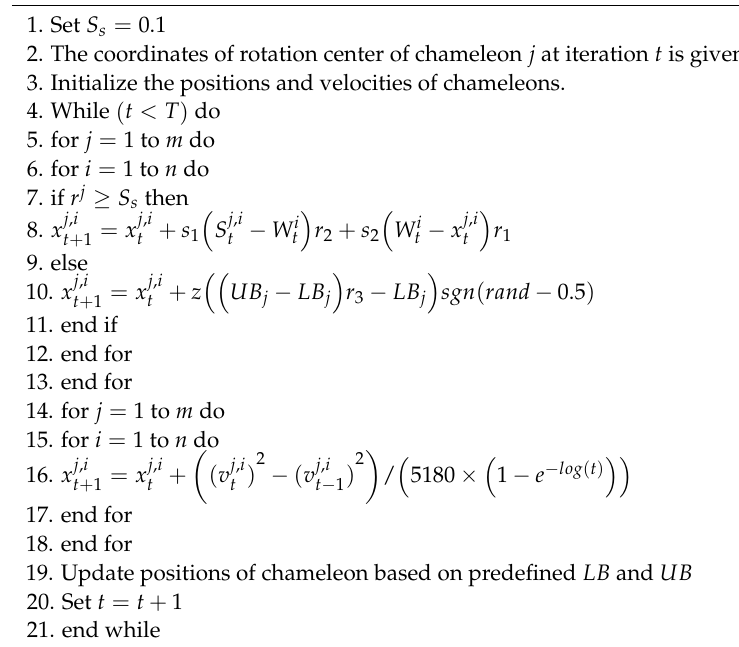
Algorithm 1. A pseudo-code of CGO algorithm.